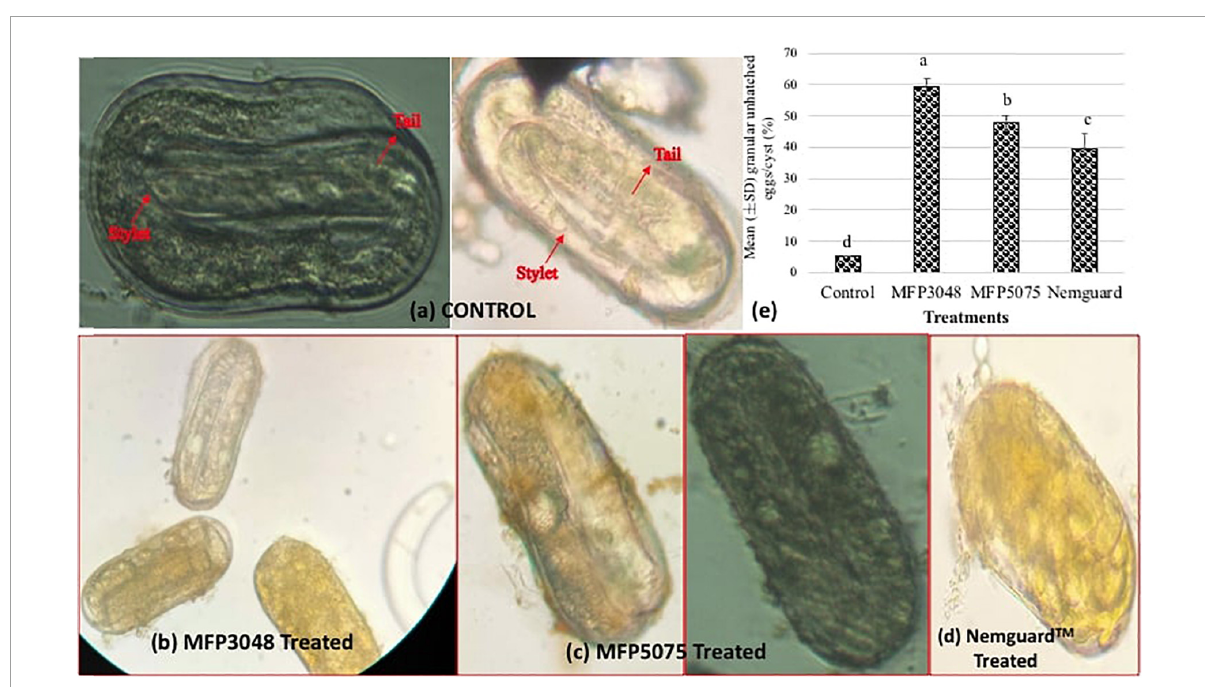
FIGURE5 Treatment with products cause granulation in the unhatched eggs. Picture of the unhatched eggs from (a) Untreated control; (b) MFP3048 treated; (c) MFP5075 treated; (d) Nemguard TM treated; (e) Percentage of granular unhatched eggs/cyst in various treatments. Data shown are mean ( ± SE) percentage of unhatched eggs that appeared granular, per cyst. Values represented in graph by the same letters are not significantly different from each other ( p ≤ 0.05).